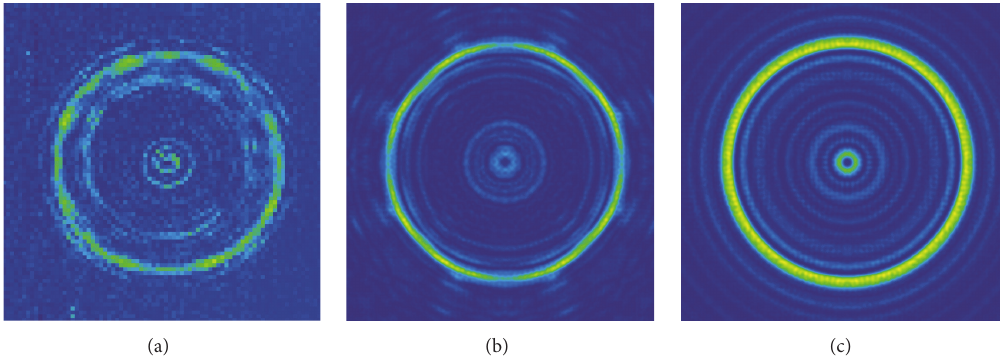
Figure 12: Experimental results (a), compared to simulation results of scanned structure (b) and ideal case